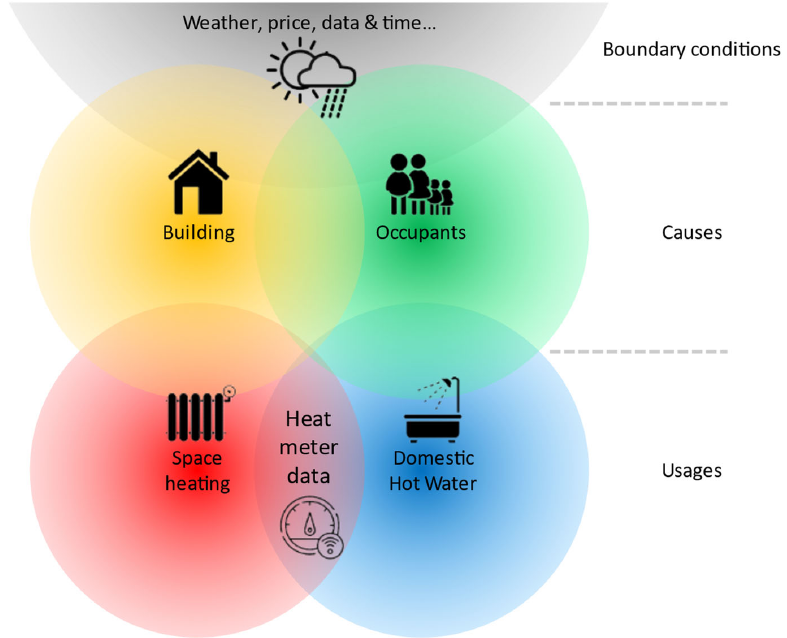
Figure 1. Conceptual representation of interactions between various factors influencing residential heat demand. One should note that the share of DHW and space heating in the total building heat demand varies significantly from buildings to buildings, depending on the occupants’ habits and the energy performance of the building envelope [14,16,21].